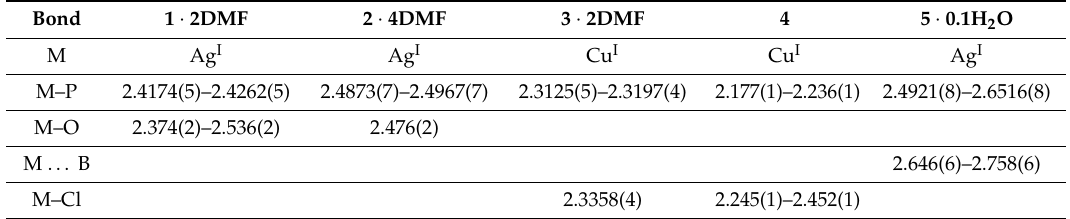
Table 2. Selected geometrical parameters (Å) of coordination polyhedra of 1–5 .